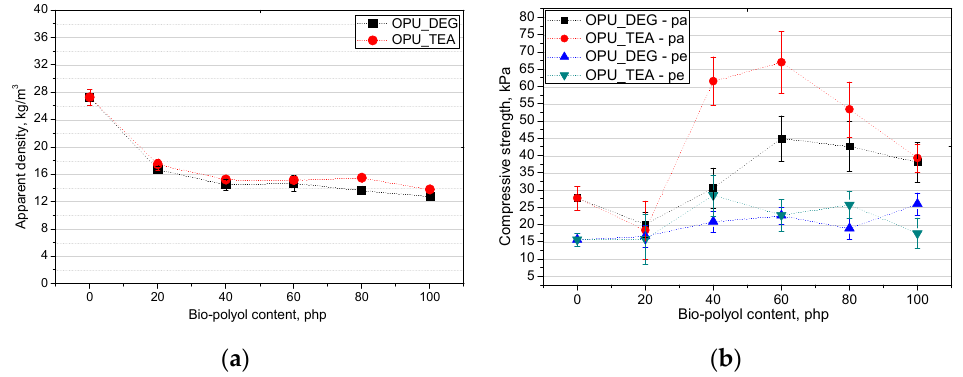
Figure 7. Influence of bio-polyols and their content on apparent density ( a ) and compressive strength ( b ) of modified foams.